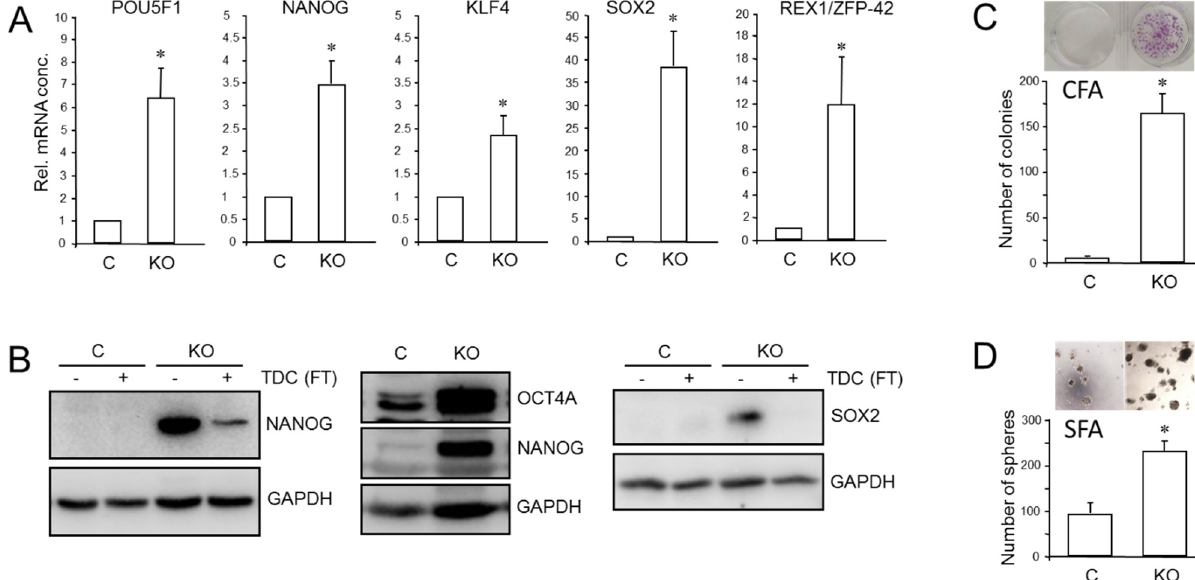
Figure 5. Effect of cellular depletion of RAC1b protein on stem cell marker expression and CSC generation in PANC-1 cells. ( A ) Expression of various stem cell-associated and self-renewal genes in PANC-1 RAC1b-KO and control cells as determined by qPCR. ( B ) Immunoblot analysis of NANOG, OCT4A, and SOX2 in PANC-1 RAC1b-KO cells. The blots shown are representative of three experiments. The left-hand and right-hand blots also contain lysates from cells that underwent TDC with FT for 5 d. ( C ) PANC-1 RAC1b-KO and control cells were seeded at a density of 40 cells/cm 2 and incubated in normal growth medium for 10 d. Cells were then fixed, stained, and colonies >50 cells counted manually. Data are from two independent experiments and represent the mean ± SD of triplicate wells. ( D ) As in ( C ) except that 1000 cells/48-well were seeded in soft agar, allowed to grow for 14 d, and then counted manually under a microscope. Data are representative of two assays and represent the mean ± SD of five parallel wells. Asterisks ( ∗ ) in ( A ), ( C ), and ( D ) indicate a significant difference relative to control cells ( p < 0.05, Student’s t -test) .